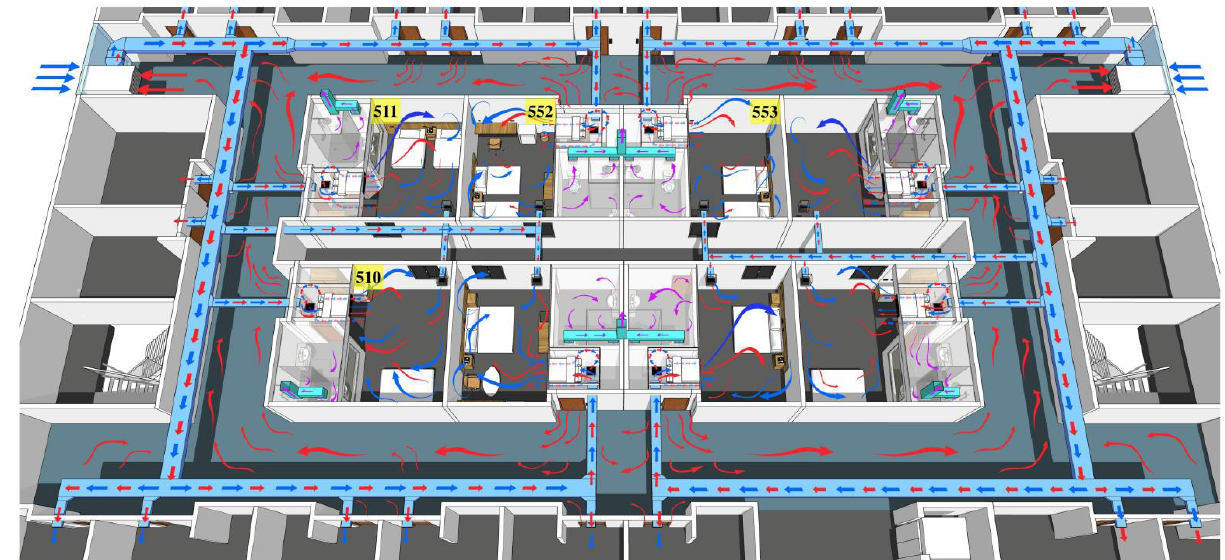
Figure 3. The layout of rooms in the hotel and schematic diagram of the transmission in the same layer. Blue arrows indicate fresh air from the outside, red arrows indicate the polluted air from rooms, and purple arrows indicate increasing contaminated air by toilet flushing.